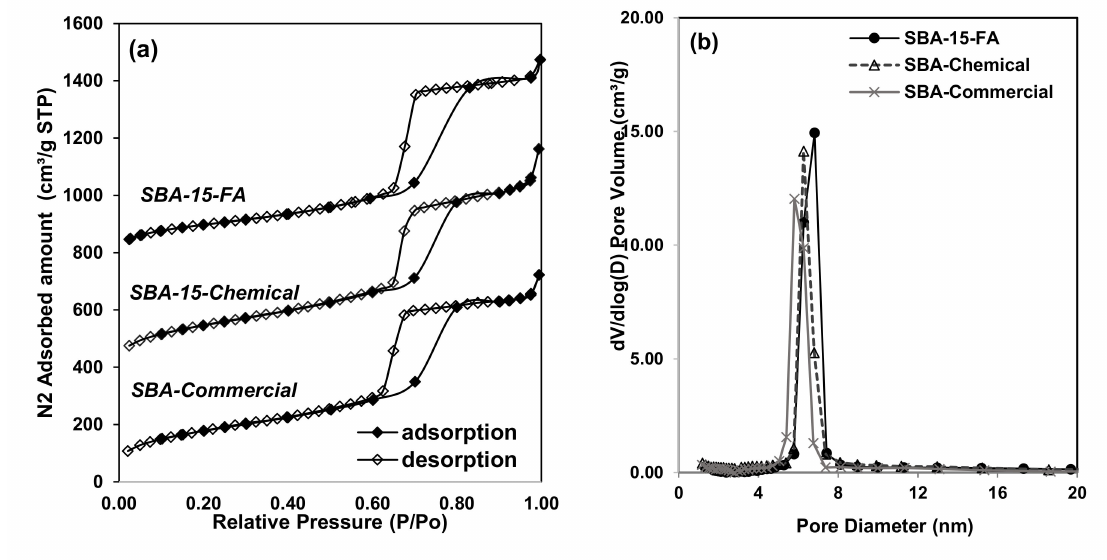
Figure 2. The N 2 adsorption–desorption isotherm ( a ) and pore size distribution curves ( b ) of SBA-15